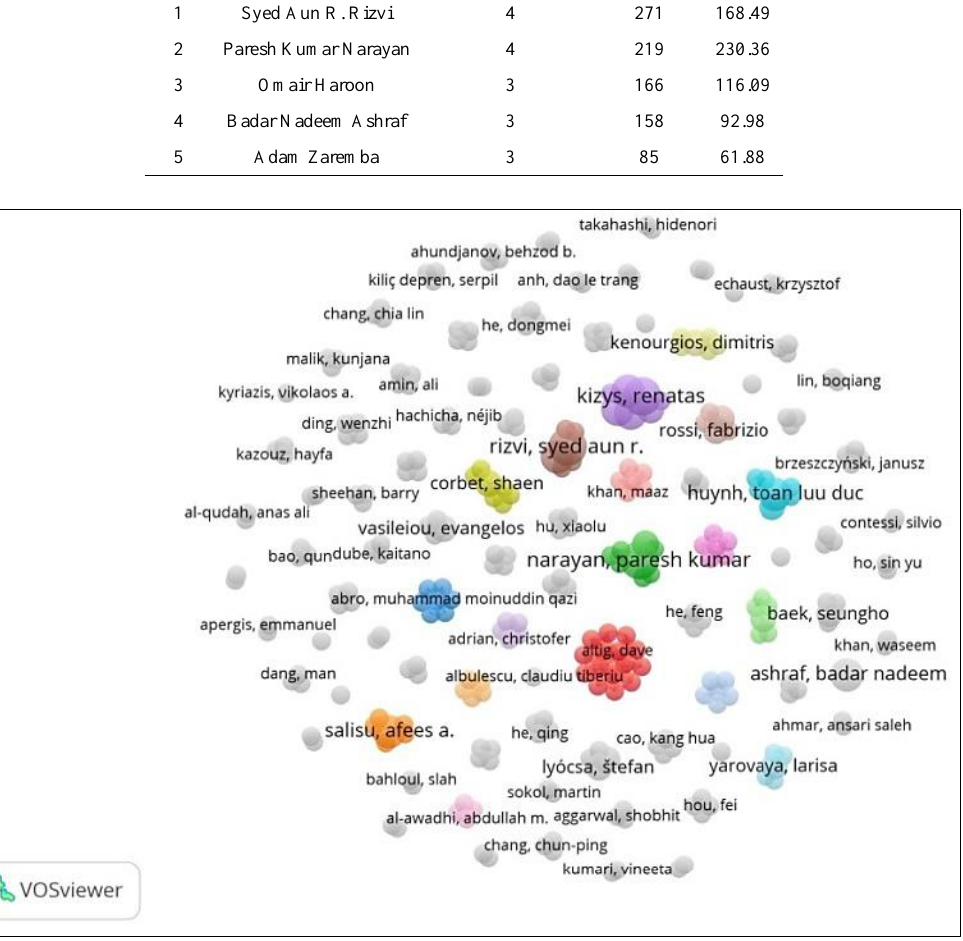
Figure 1. Network Visualization (All Authors)